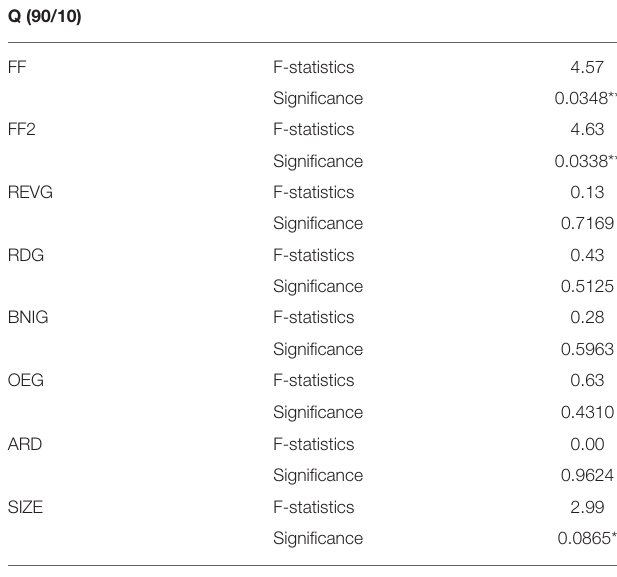
TABLE 5 | Inter-quantile regression results.